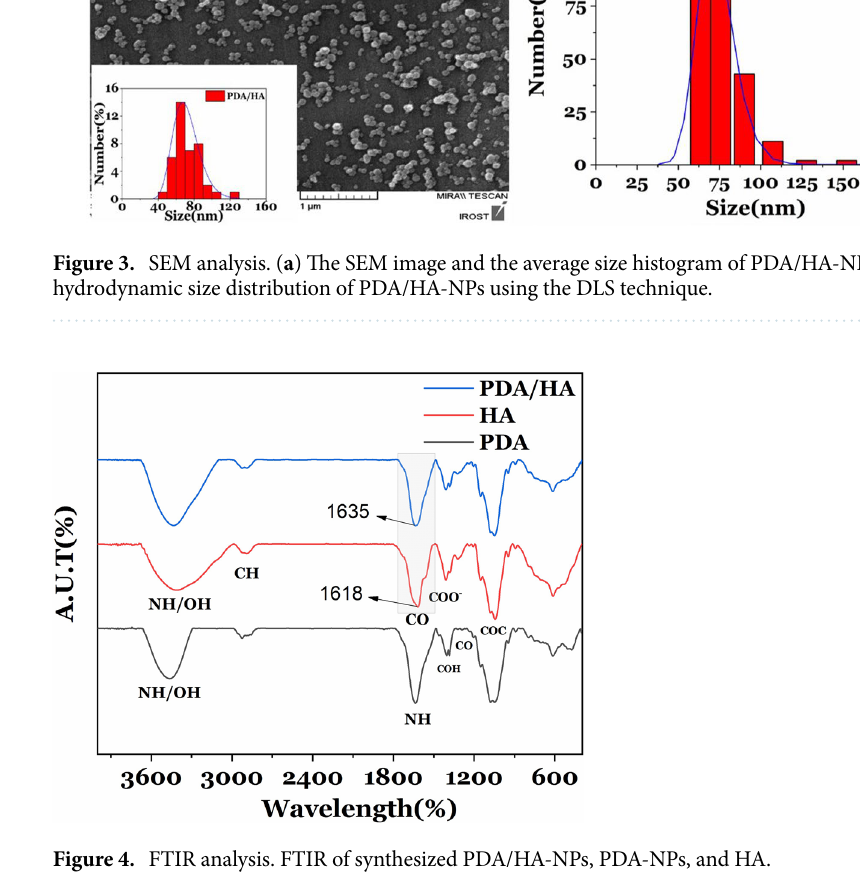
Figure 4. FTIR analysis. FTIR of synthesized PDA/HA-NPs, PDA-NPs, and HA.